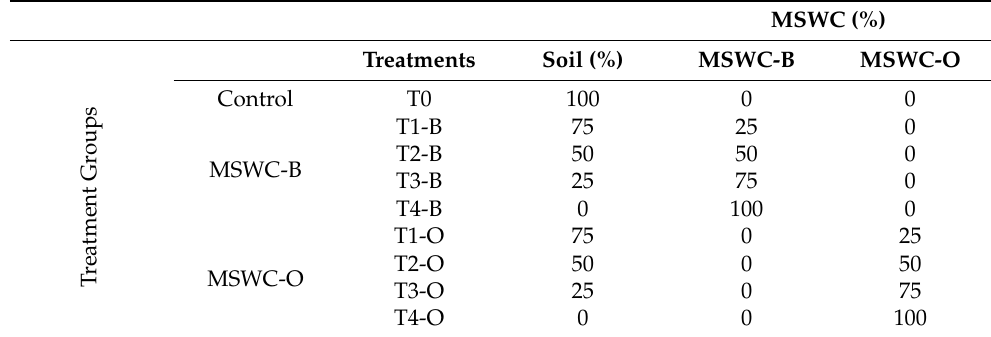
Table 1. Percentage composition of prepared treatments using two MSWCs collected from different plants. MSWC (%) Treatments Soil (%)